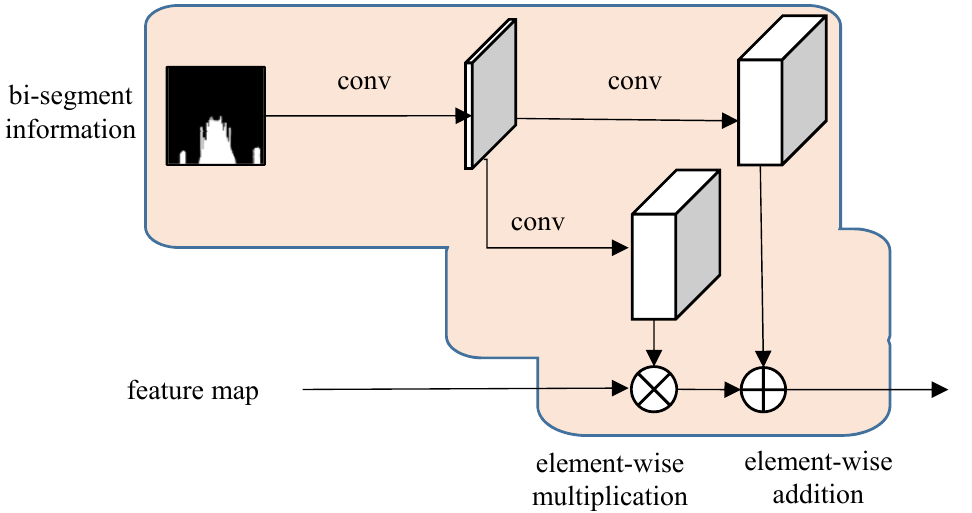
Figure 3. The structure of SPADE module in our generator.